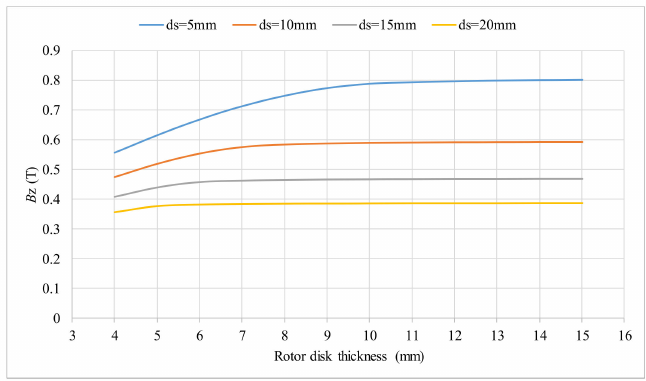
Figure 5. Rotor disks thickness influence on the size of B